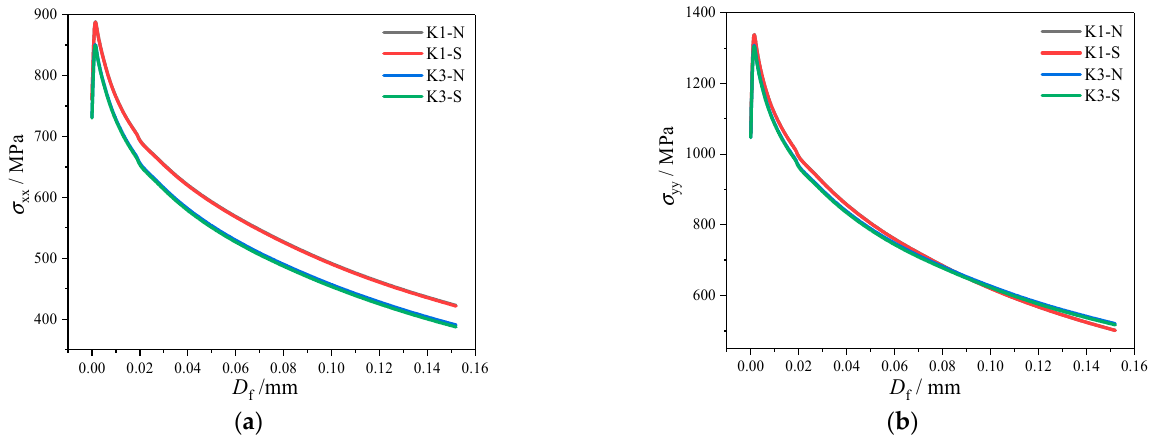
Figure 5. Stress distribution under tensile loading: ( a ) σ xx ; ( b ) σ yy.